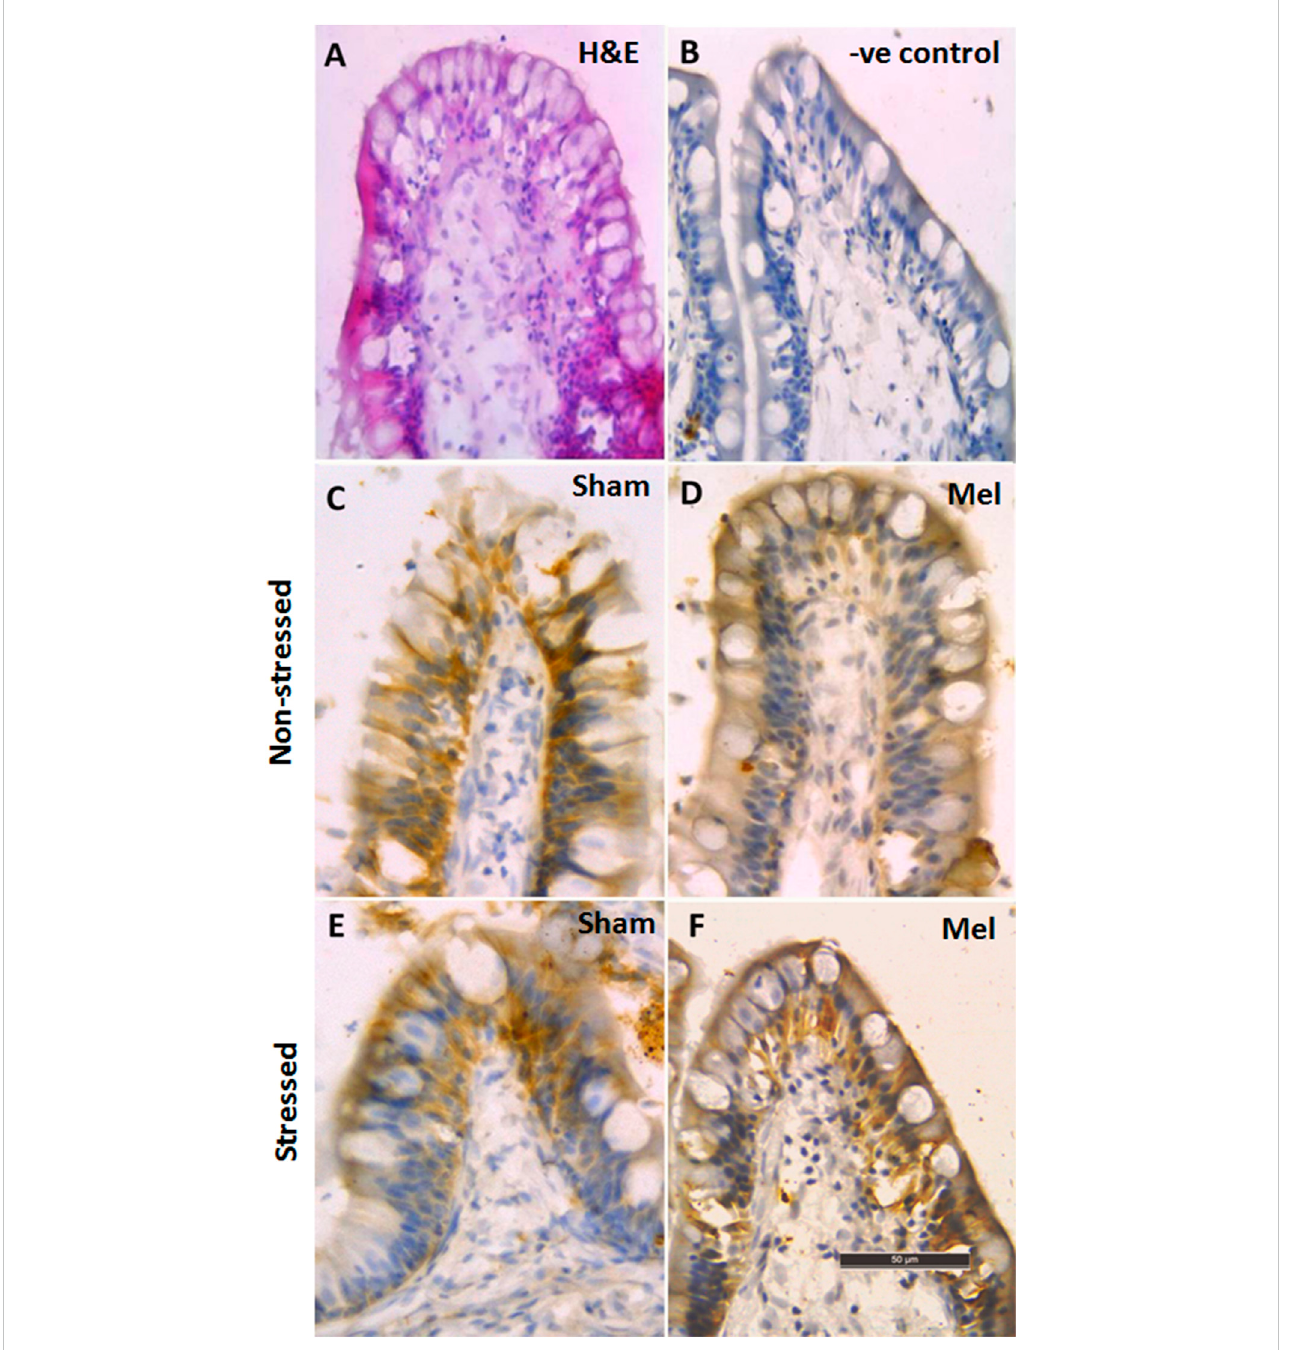
FIGURE 9 ImmunohistochemicalphotomicrographsofintestinalvilliinclimbingperchshowingimmunoreactivityofNKA α -antibody.Cryostatsectionsofintestinal villi showing the distribution pattern of enteric ionocytes by H&E staining (A) in non-stressed fi sh control (C) and immersion-stressed fi sh control (E) . Melatonin (50 ng g − 1 ; Mel) was given to non-stressed (D) and immersion stressed (F) ; IMR) fi sh. Negative controls were kept under the same conditions without primary antibody that yielded no immunoreactivity (B) . Scale bar = 50 μ